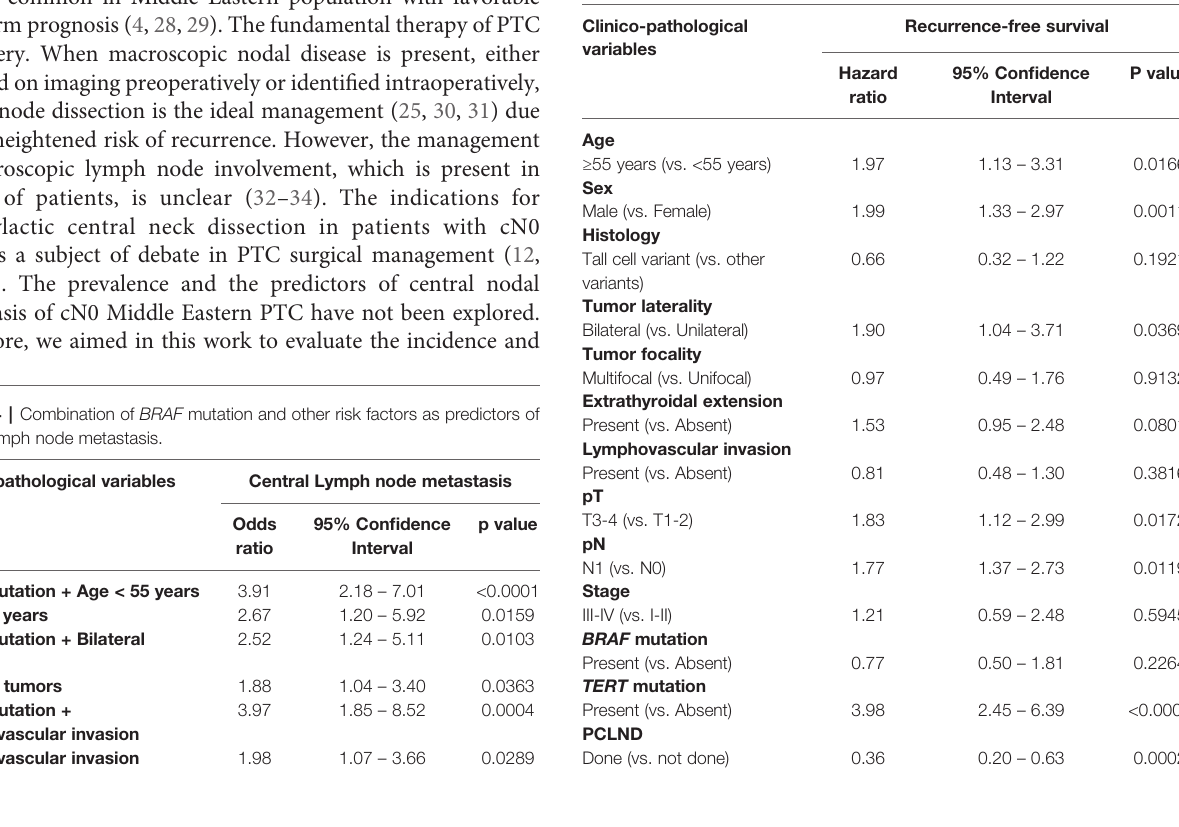
TABLE 5 | Independent predictors of recurrence-free survival in papillary thyroid